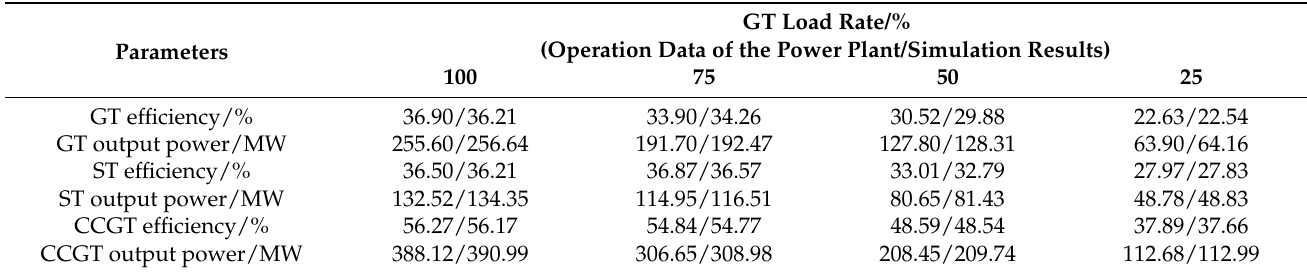
Table 2. Comparison of the calculation